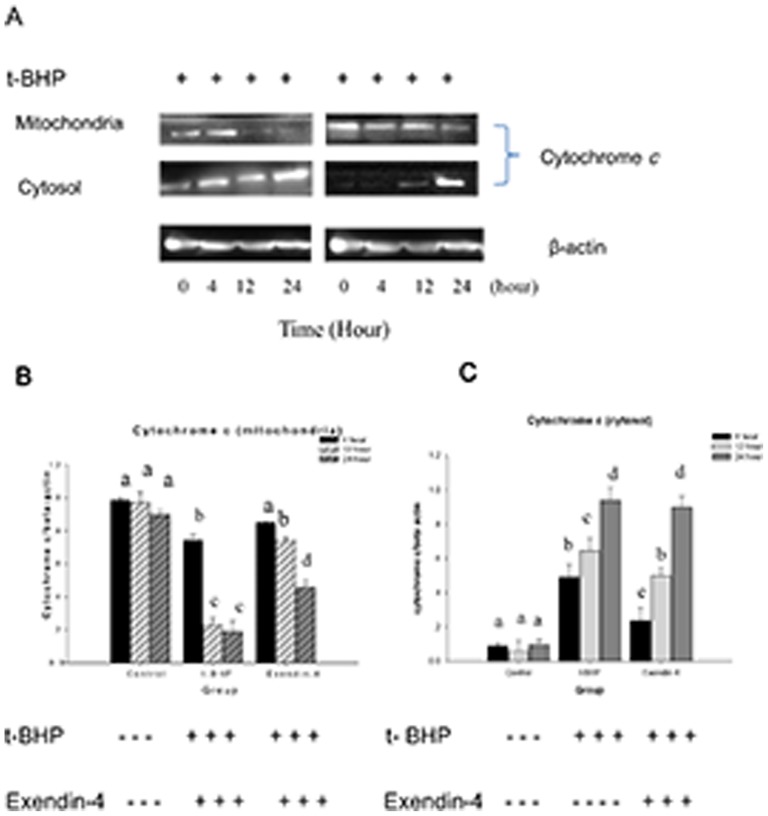
Exendin-4 attenuates the release of cytochrome c from the Min6 cell mitochondria.Figure A shows the effect of Exendin-4 on cytochrome c in Min6 cells. The cells were treated with or without Exendin-4 and then with t-BHP for different intervention times. The cells were then collected, and cytoplasmic mitochondrial fractions were prepared using a mitochondrial/cytosol fraction kit. The samples from each fraction were analyzed using Western blot for cytochrome c. Figure B presents the mitochondria. Figure C includes the group gray comparison (cytoplasm). The data are expressed as the means±S.D. (n = 6). a, b, c, d and e indicate the blank comparison and the t-BHP (200 µM for 24 hours) and Exendin-4 (100 µM for 48 hours) group comparisons (p<0.05).